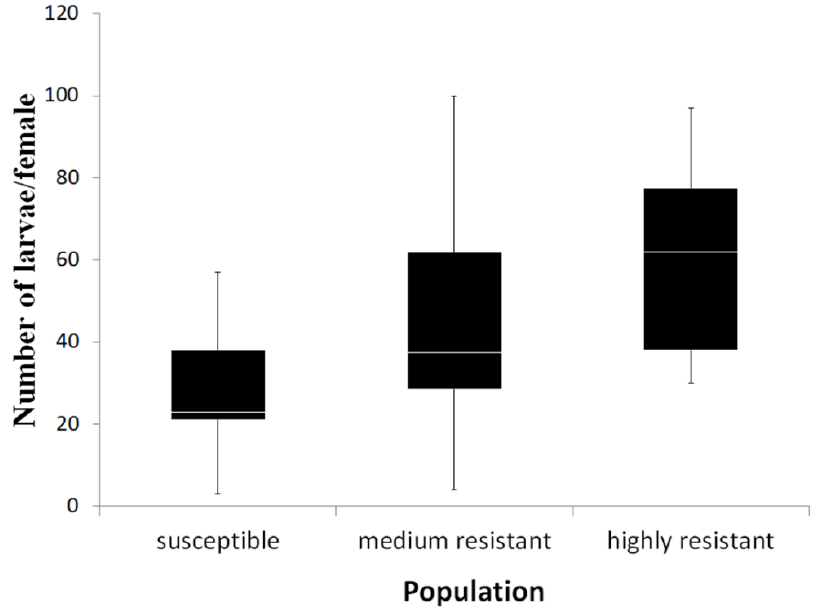
Figure 6. Fecundity presented as the number of larvae (2nd instar) per female in the three thrip populations used (ANOVA, n ≤ 13, df = 2, p =